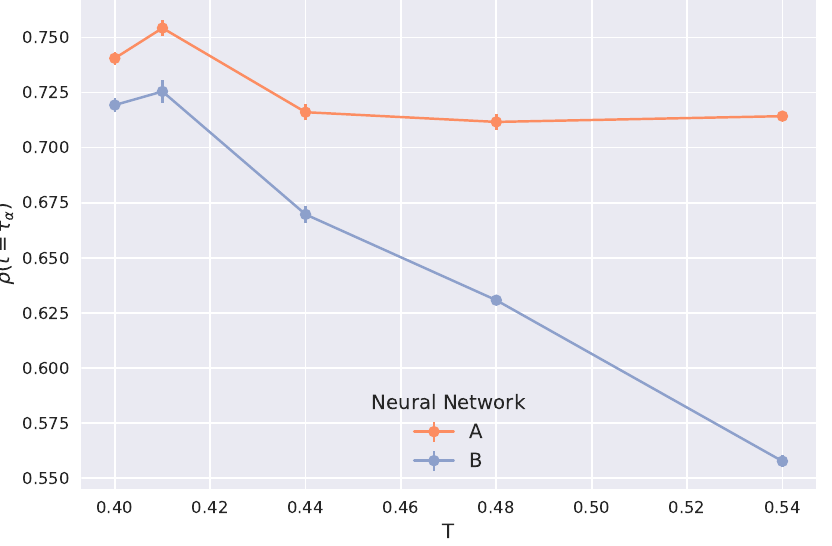
Figure 5. Comparison of the prediction accuracy at t = τ α in either the presence (NN A ) or the absence (NN B ) of the local DW in the input features